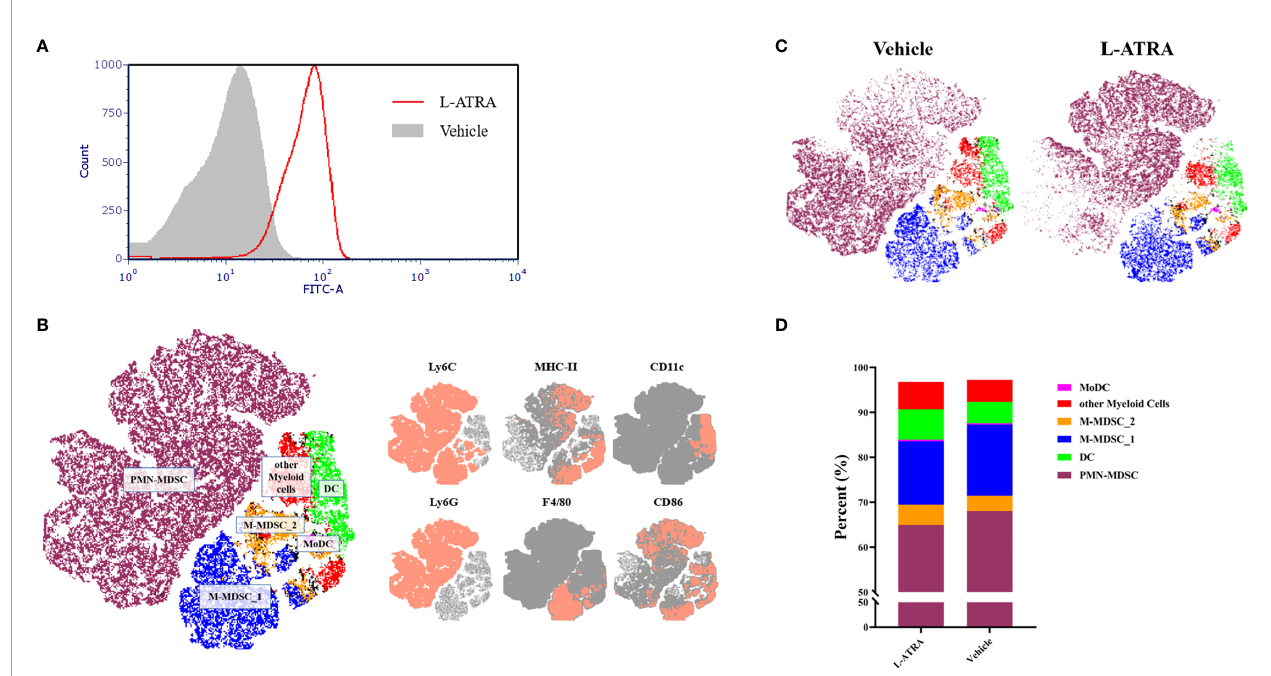
FIGURE 5 | The analysis of PBMCs after L-ATRA treatments in syngeneic CT26 colon cancer mice. (A) The interactions between fl uorescent labeled L-ATRA with primary PBMCs in vitro ; (B) The merged t-distributed stochastic neighbor embedding (tSNE) plots of CD11b+ myeloid cells in PBMCs. Cells were pro fi led by fl ow cytometry and clustered for the ident fi cation of various immune cell populations (left). The marker expression schemes were also shown (right); (C) Comparisons of the tSNE plots of CD11b + myeloid cells in PBMCs with or without L-ATRA treatments; (D) The myeloid cell compositions in PBMCs with or without L-ATRA